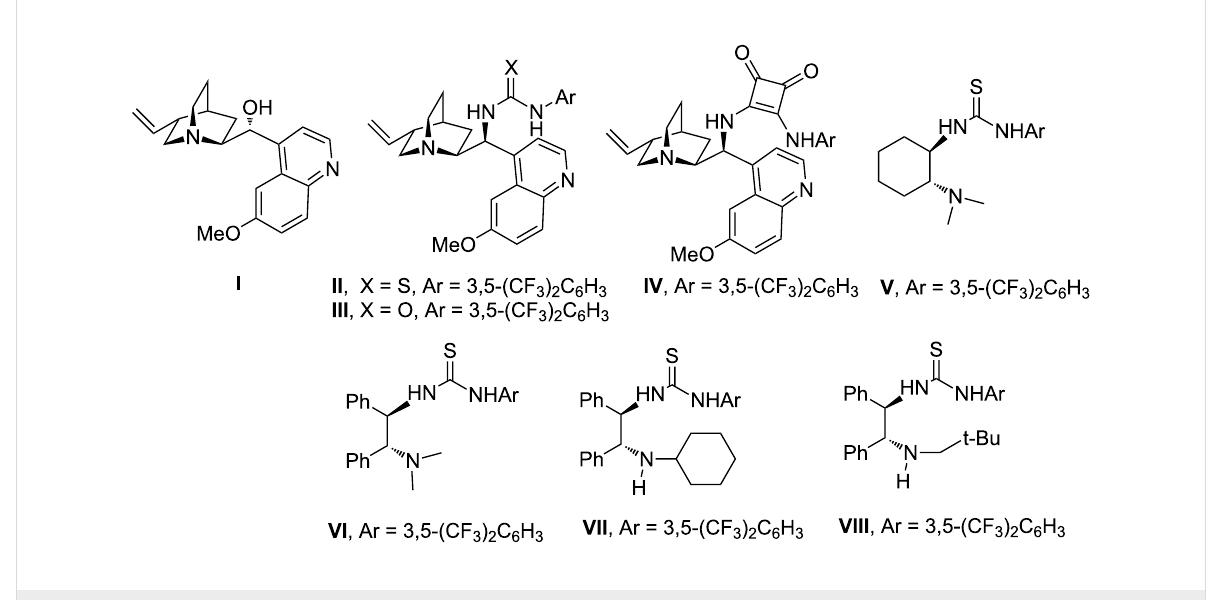
Scheme 1: Organocatalysts screened in the cascade